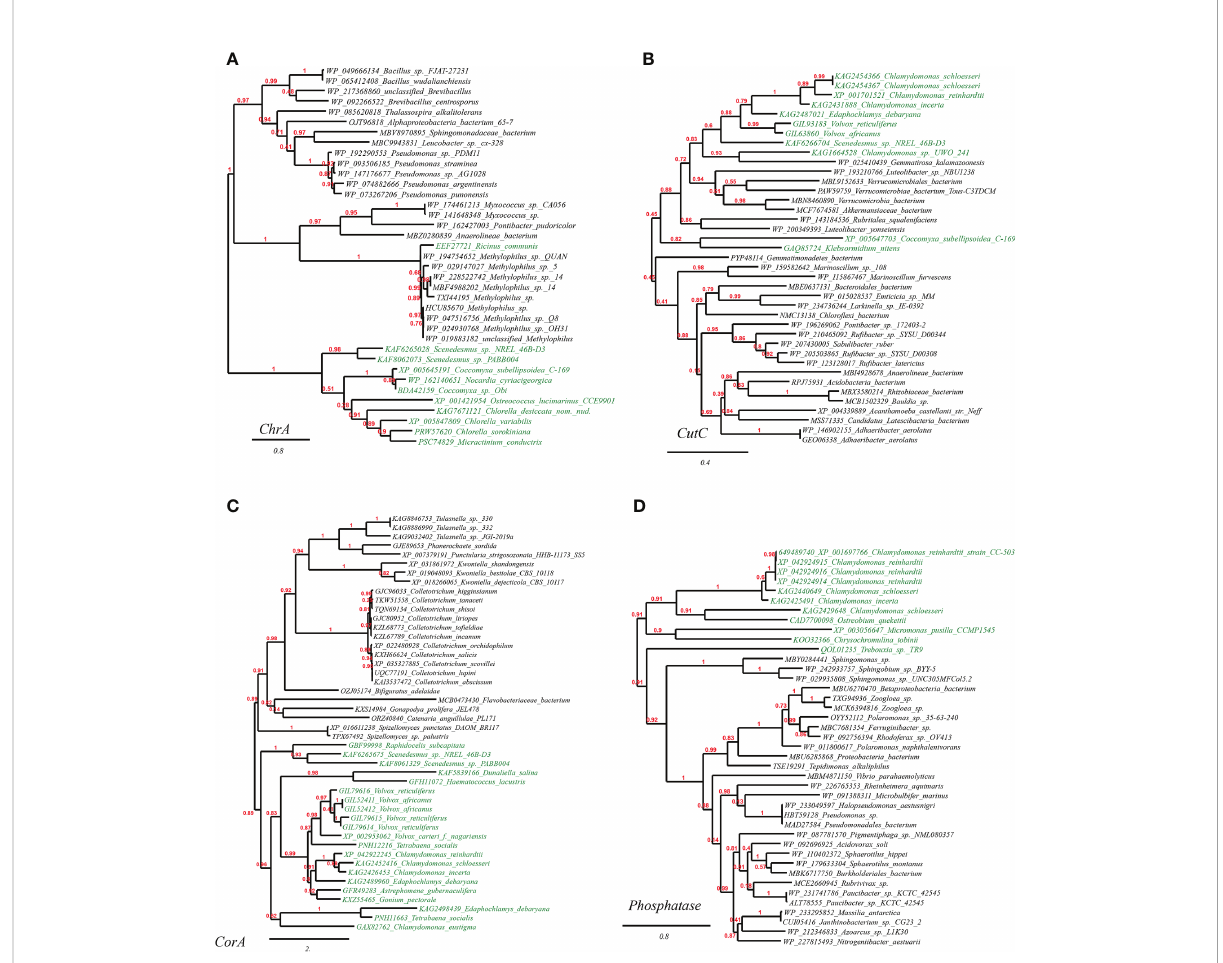
FIGURE 1 Phylogenetic tree of metal resistance proteins in plant genomes originated from microbial taxa. The phylogeny construction was conducted based on gene-translating protein sequences using PhyML program with the Maximum Likelihood (ML) method and 1,000 bootstrap replicates (with bootstrap values in red showing on respective branches). Branches leading to plant taxa are marked by green color, whereas those belonging to microbial lineages are in black: (A) chromate transporters (ChrA); (B) copper homeostasis protein (CutC); (C) magnesium and cobalt transport protein (CorA). (D)